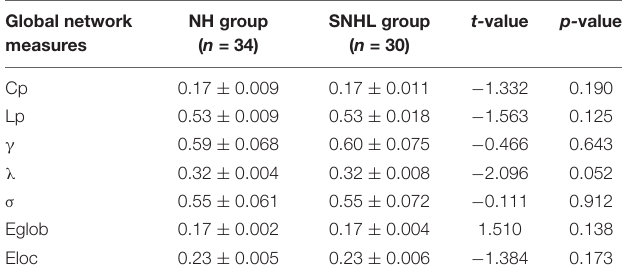
TABLE 2 | Global network parameters in NH group and SNHL